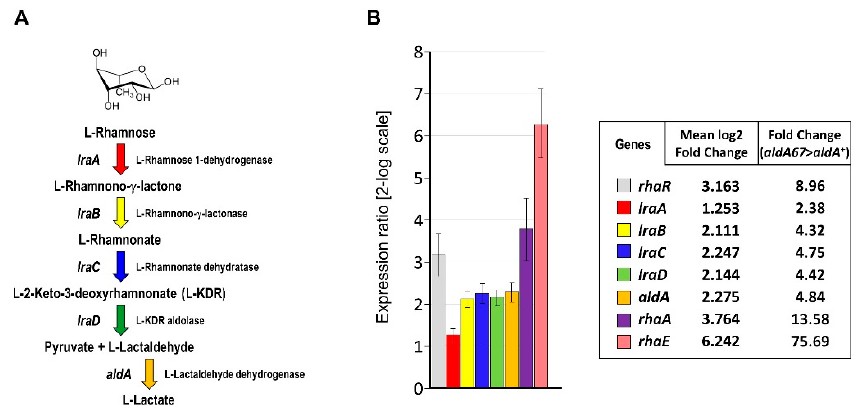
Figure 1. Enhanced expression of the RHA/RhaR genes in the aldA loss-of-function mutant aldA67 under inducing conditions: ( A ) biochemical route (LRA) of L-rhamnose catabolism in A. nidulans ; ( B ) relative transcript abundance in the aldA67 mutant (AR463) compared to the control strain AR462 ( aldA + ) after transfer of mycelia to inducing conditions (1% L-rhamnose), as determined by RT-qPCR.